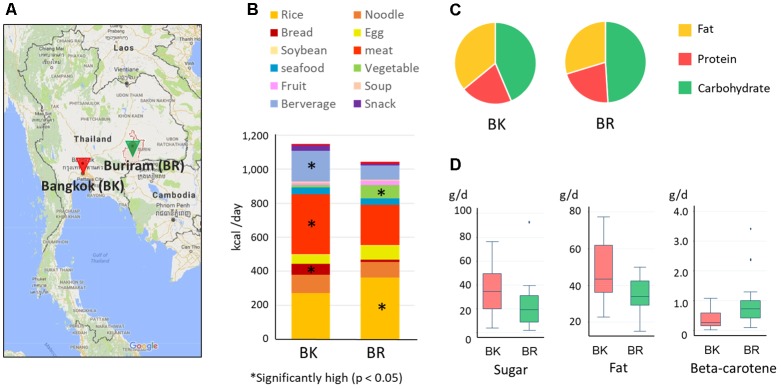
Sampling cities and diets of participants in this study. (A) Map of Bangkok and Buriram. The map was generated based on Google Maps 2017 (https://www.google.com/maps/). “BK” and “BR” were used as abbreviations. (B) Average daily dietary intake for participants in the two cities. The contribution of each food group was estimated from the 7-day dietary record reported by participants’ parent/guardian and was converted to energy units (kcal) according to databases of food energy and nutrition. Asterisks indicate statistically significant differences (p < 0.05) by Wilcoxon rank-sum test. More detailed information on food consumption is shown in Supplementary Tables S1, S2. (C) The energy ratio of macronutrients consumed daily in BK and BR children. (D) The nutrients in foods consumed daily showing statistically significant differences between BK and BR children (p < 0.05 by Wilcoxon rank-sum test). The box plots show the smallest and largest values, 25 and 75% quartiles, medians, and outliers.